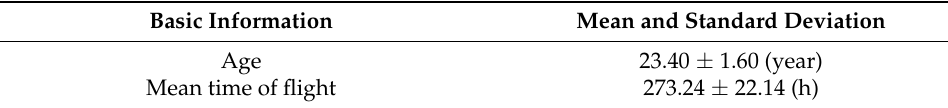
Table 3. Basic information of the participants.